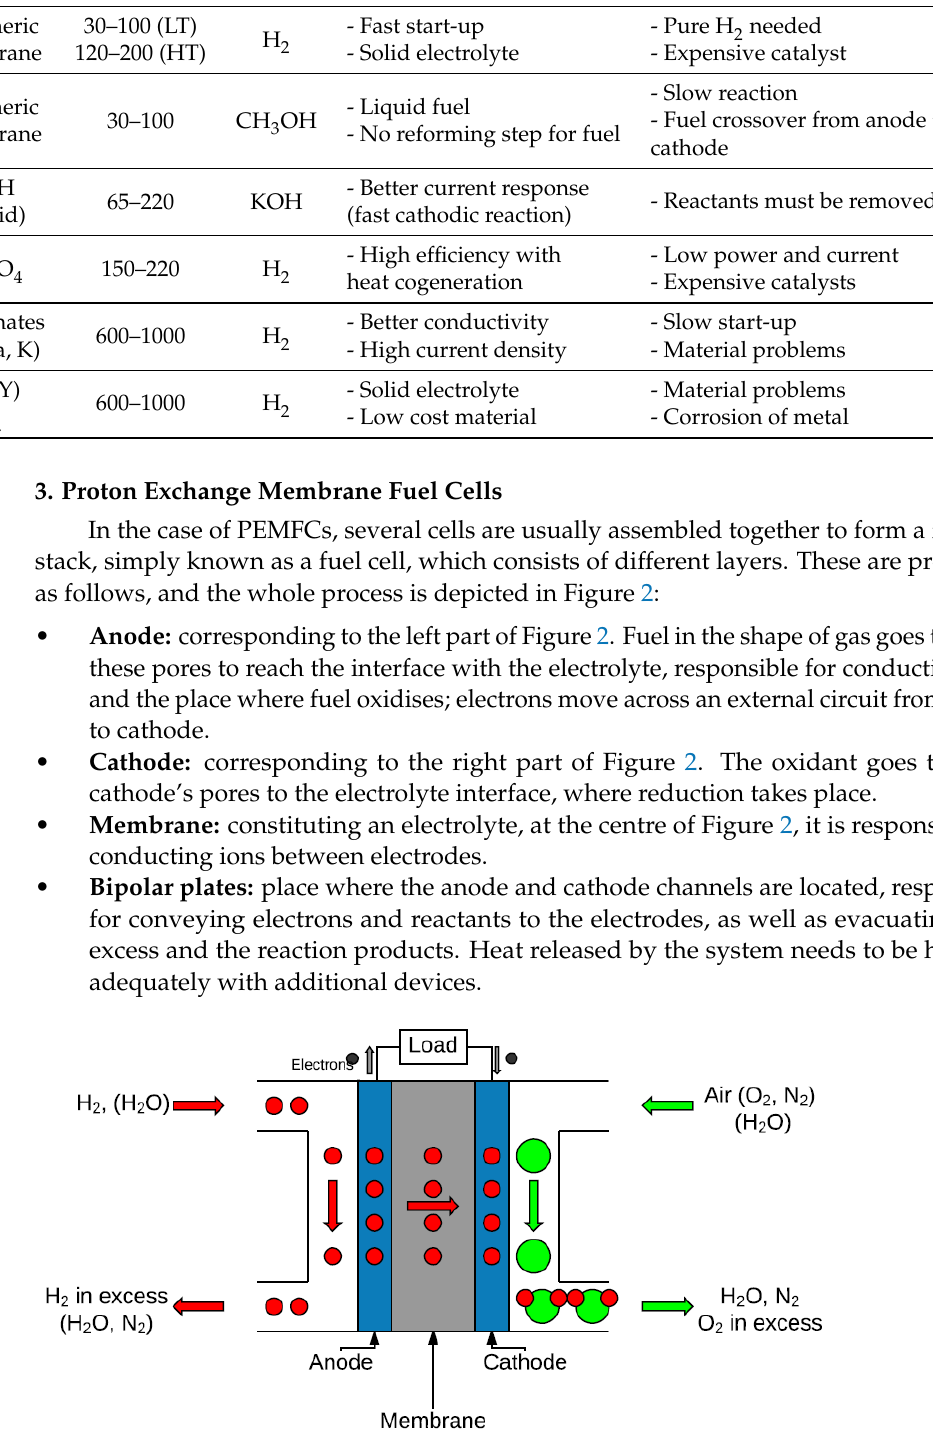
Figure 2. Fuel cell